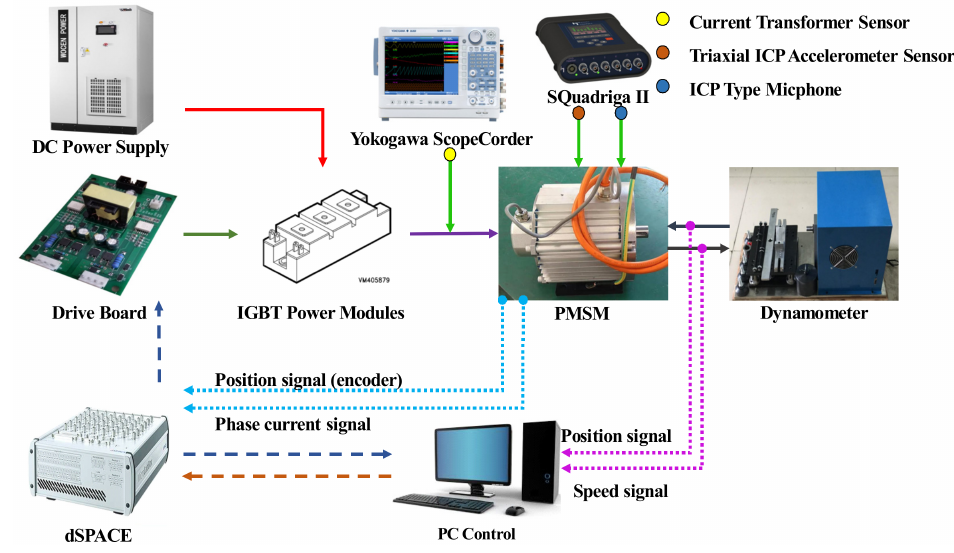
Figure 5. Overview of the test platform.